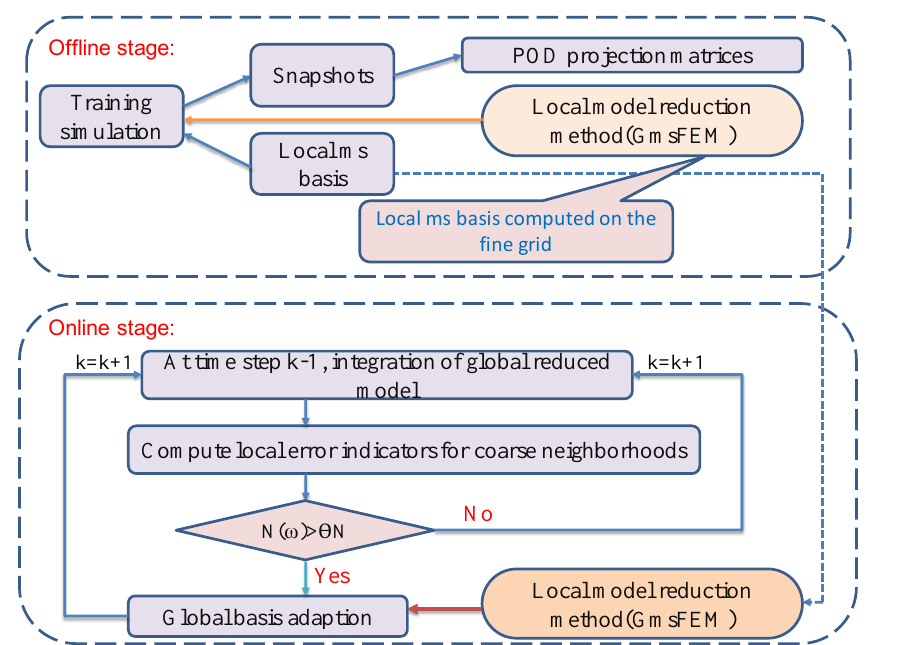
Figure 2. Flowchat of the online adaptive local-global POD